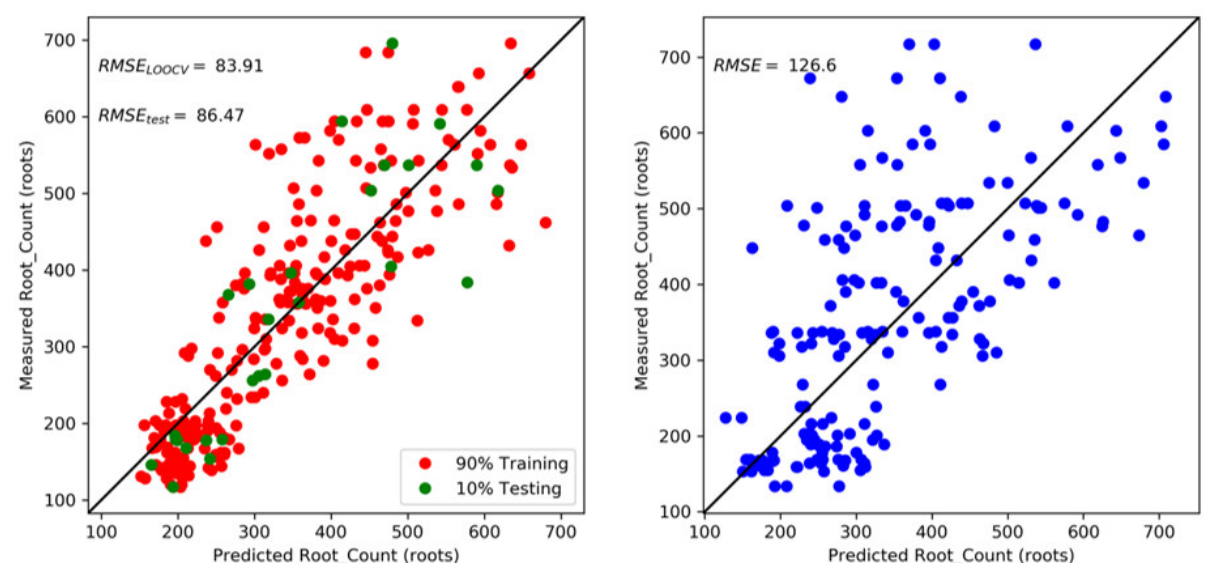
Figure 6. The area-augmented table beet root count  2 ( left ) and  ( right ) leave-one-out cross-validation perfor- mance (y-axis) for individual multiple linear regression models. Each model consists of one reflectance band or vegetation index shown on the x-axis combined with canopy area. The DVI paired with table beet canopy area was the best-perform- ing model with  2 = 0.7 0 and  = 84 roots.